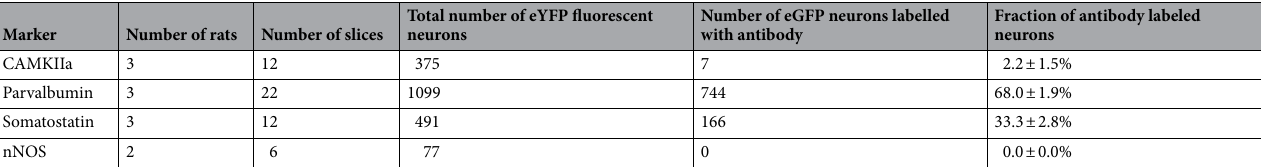
Table 5. Summary of rAAV2-PV-eGFP co-expression in